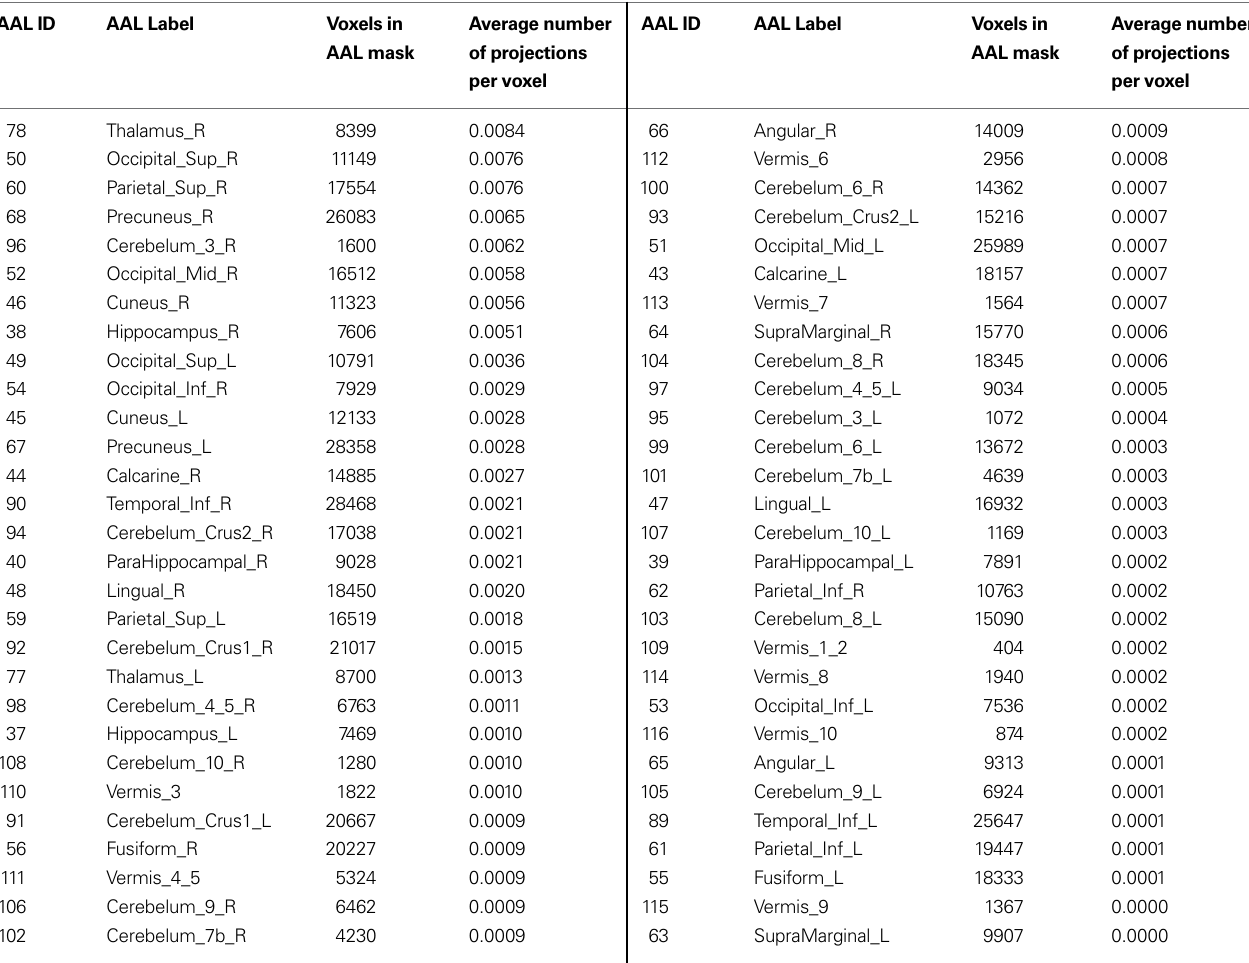
Table 1 | Regions of interest for the network